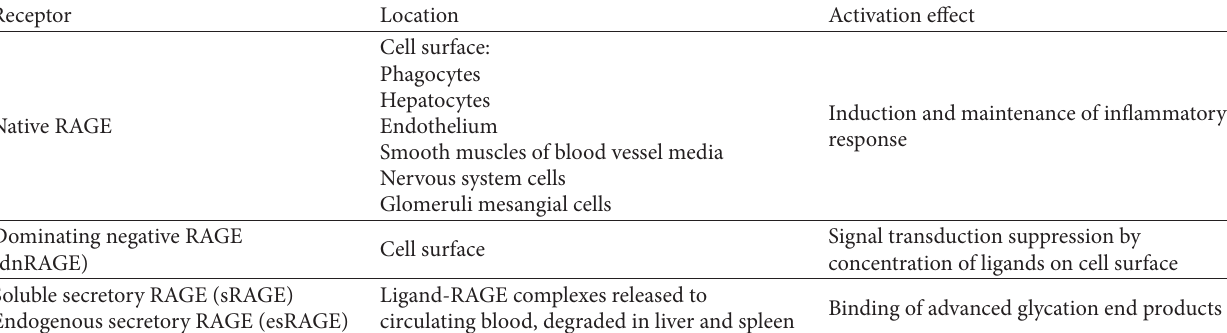
Table 2: The RAGE variants